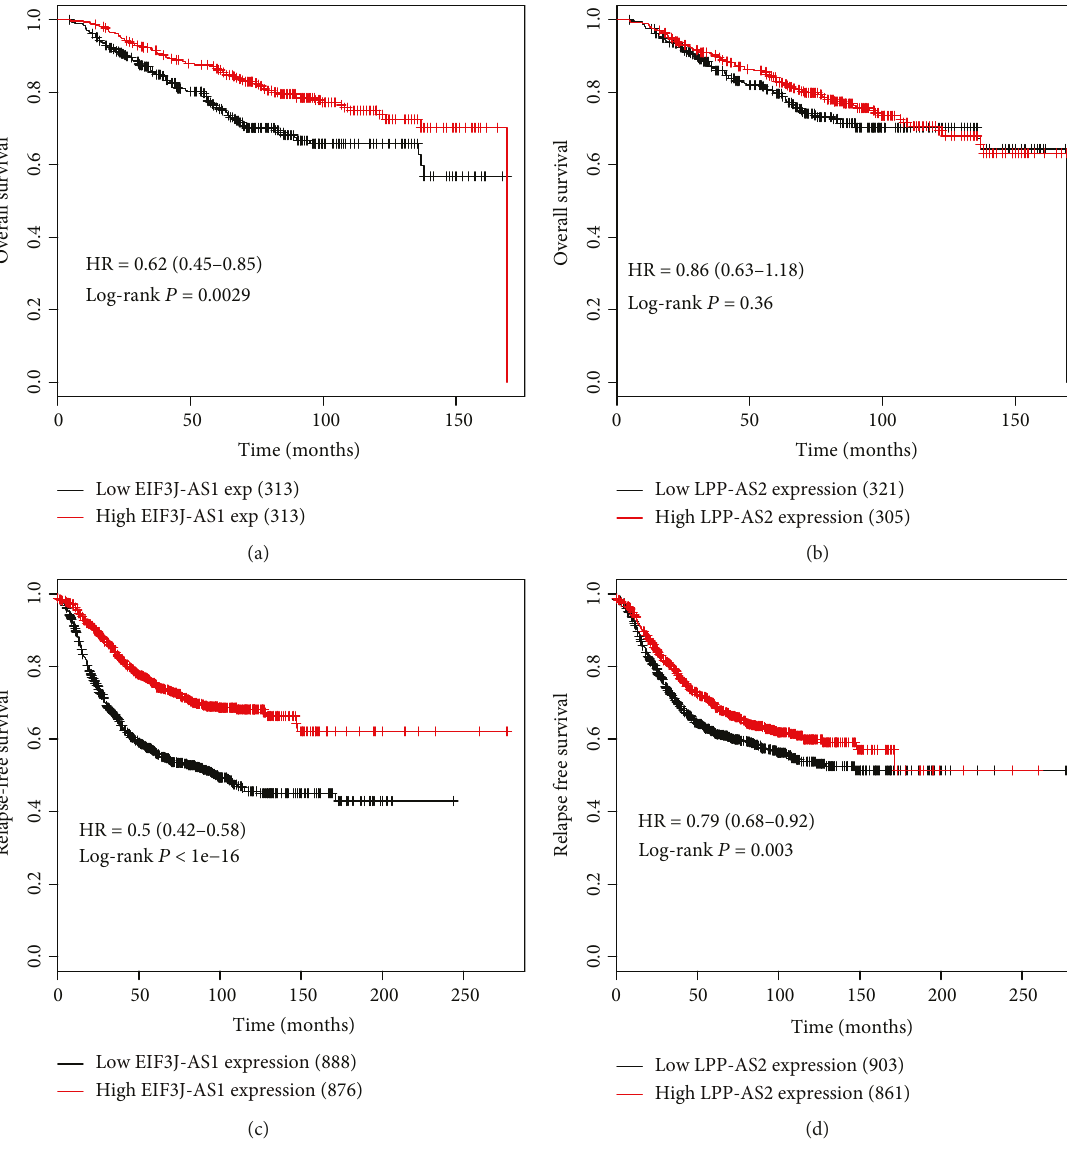
Figure 5: Prognostic potential of EIF3J-AS1 and LPP-AS2. (a) According to the Kaplan – Meier plot, patients with high EIF3J-AS1 expression have better overall survival. (b) Patients with high LPP-AS2 expression do not have di ff erent overall survival, compared to patients with low LPP-AS2 expression. (c) Patients with high EIF3J-AS1 expression have better relapse-free survival. (d) Patients with high LPP-AS2 expression have better relapse-free